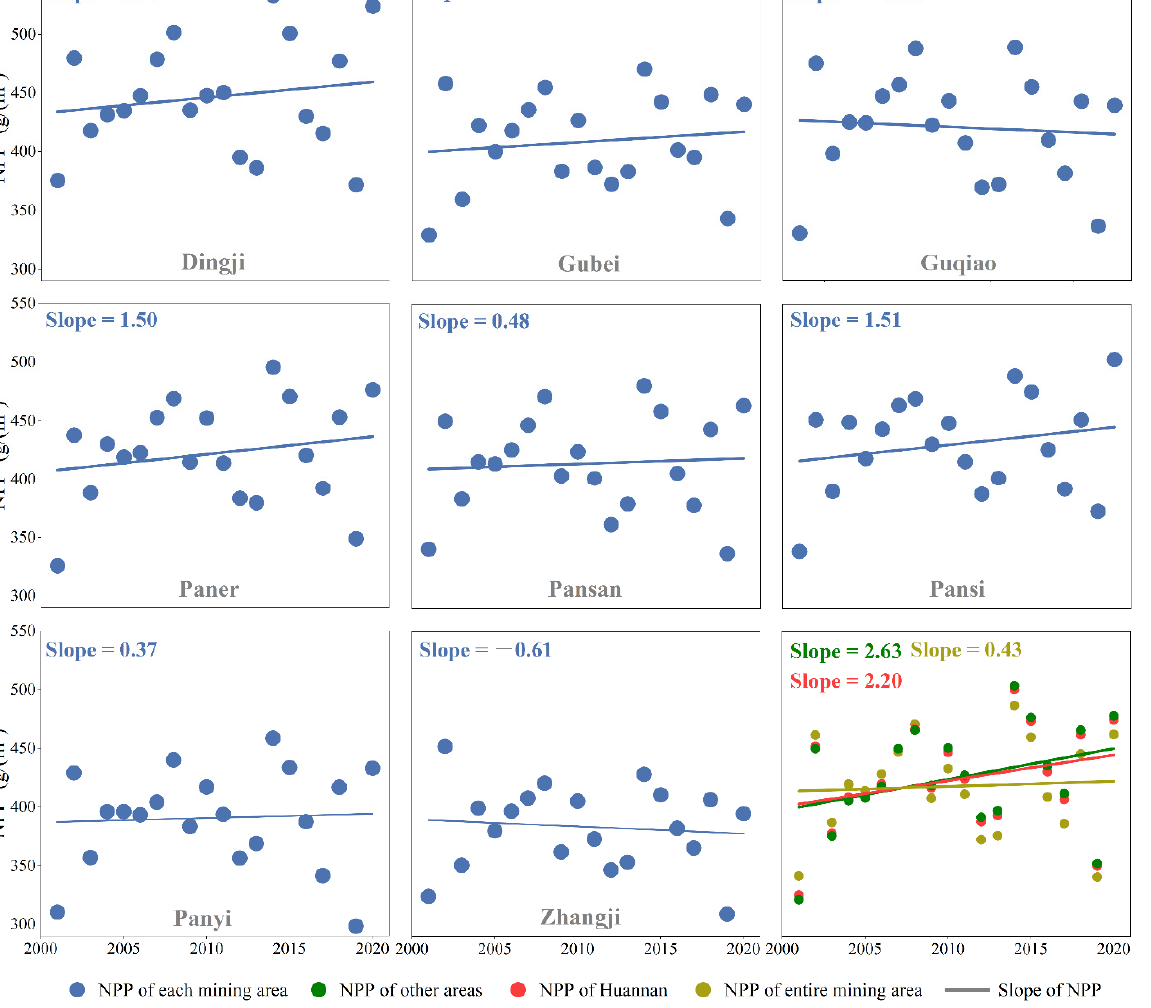
Figure 6. NPP change trend from 2001 to 2020 in coal mines and in Huainan.